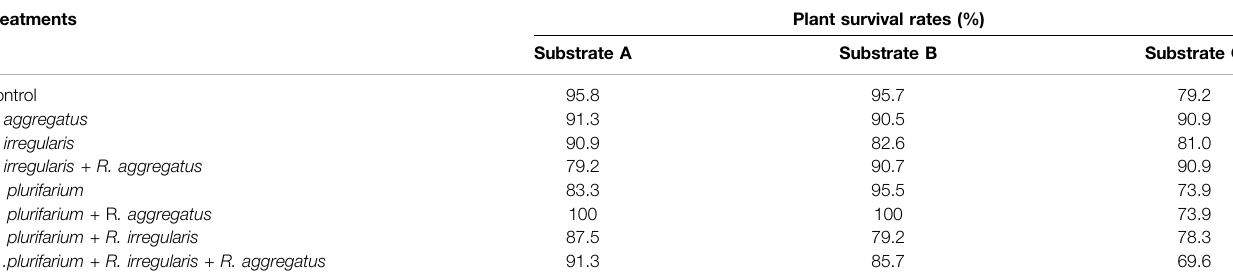
TABLE 6 | Survival rates (%) at 72 months after transplantation of S. senegal seedlings that were grown on different inoculated or uninoculated substrates in fi eld mine.